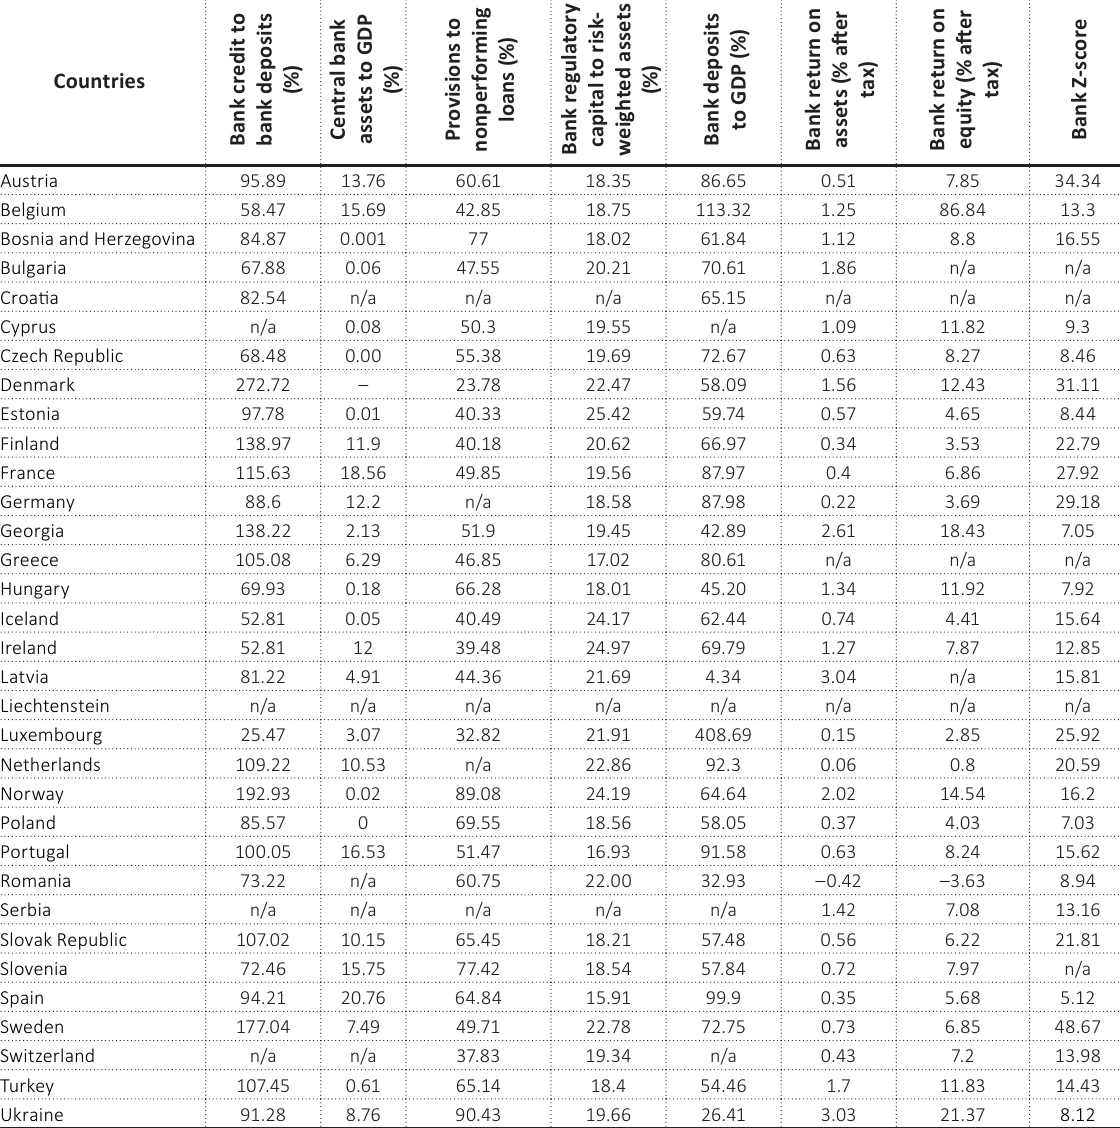
Table B1. Data for calculations based on the DEA method in the European countries as of